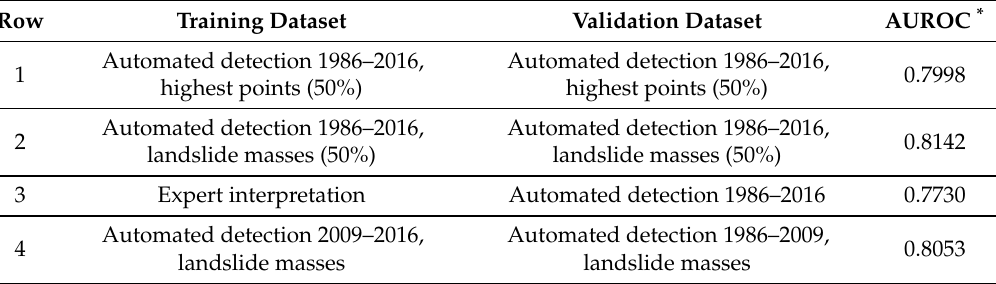
Table 4. Validation results.